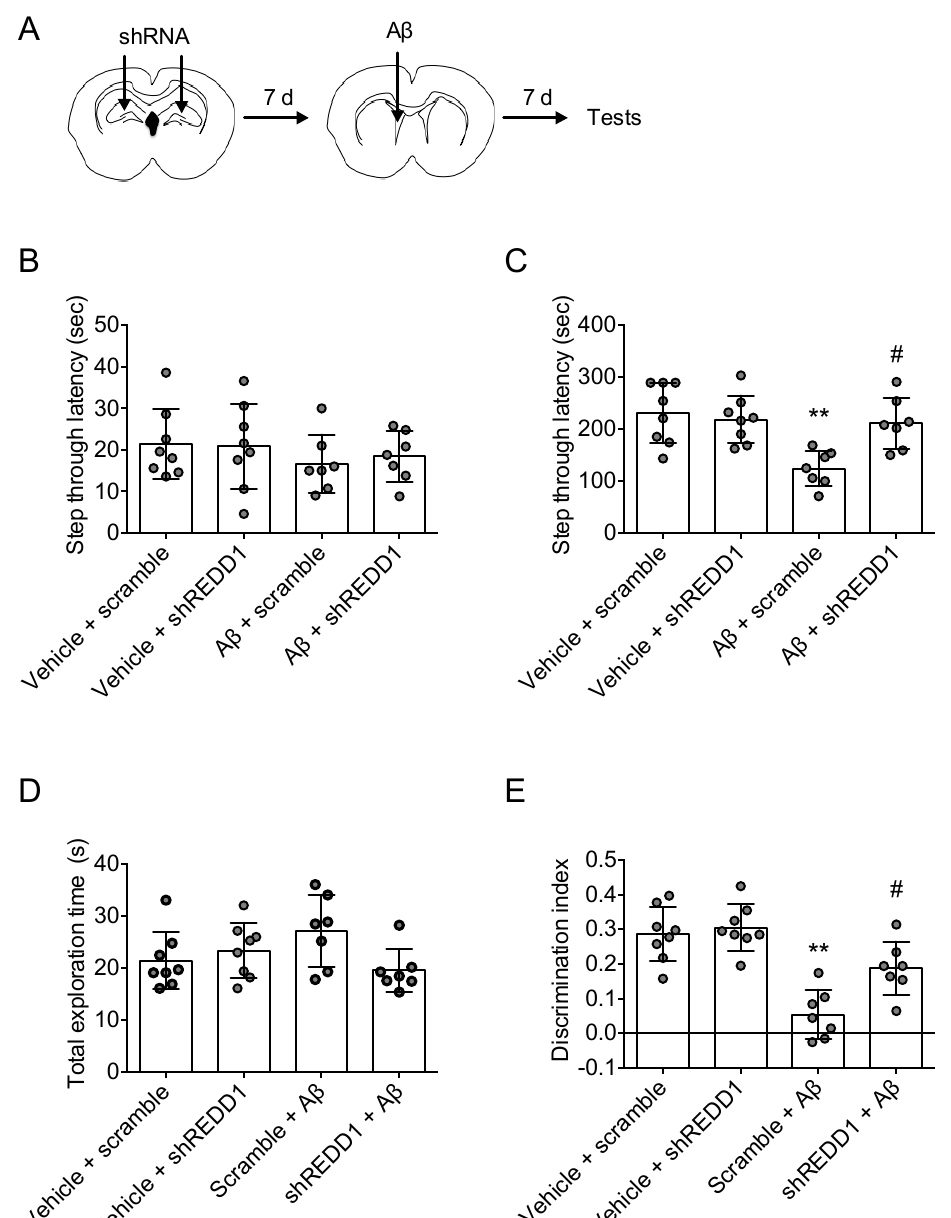
Figure 4. REDD1 reduction rescued A β -induced memory impairment. ( A ) REDD1 shRNA (m) lentiviral particle or control lentiviral particle was bilaterally injected into hippocampal fissure layer. A β was injected into the lateral ventricle 7 d later than the shRNA injection was. ( B , C ) REDD1 knockdown blocked A β -induced passive-avoidance memory deficit. Data represented as mean ± SD. ** p < 0.01 vs. sham group; # p < 0.05 vs. scramble + A β group. ( D , E ) REDD1 knockdown blocked A β -induced object-recognition memory deficit. Data represented as mean ± SD. # p < 0.05. ** p <